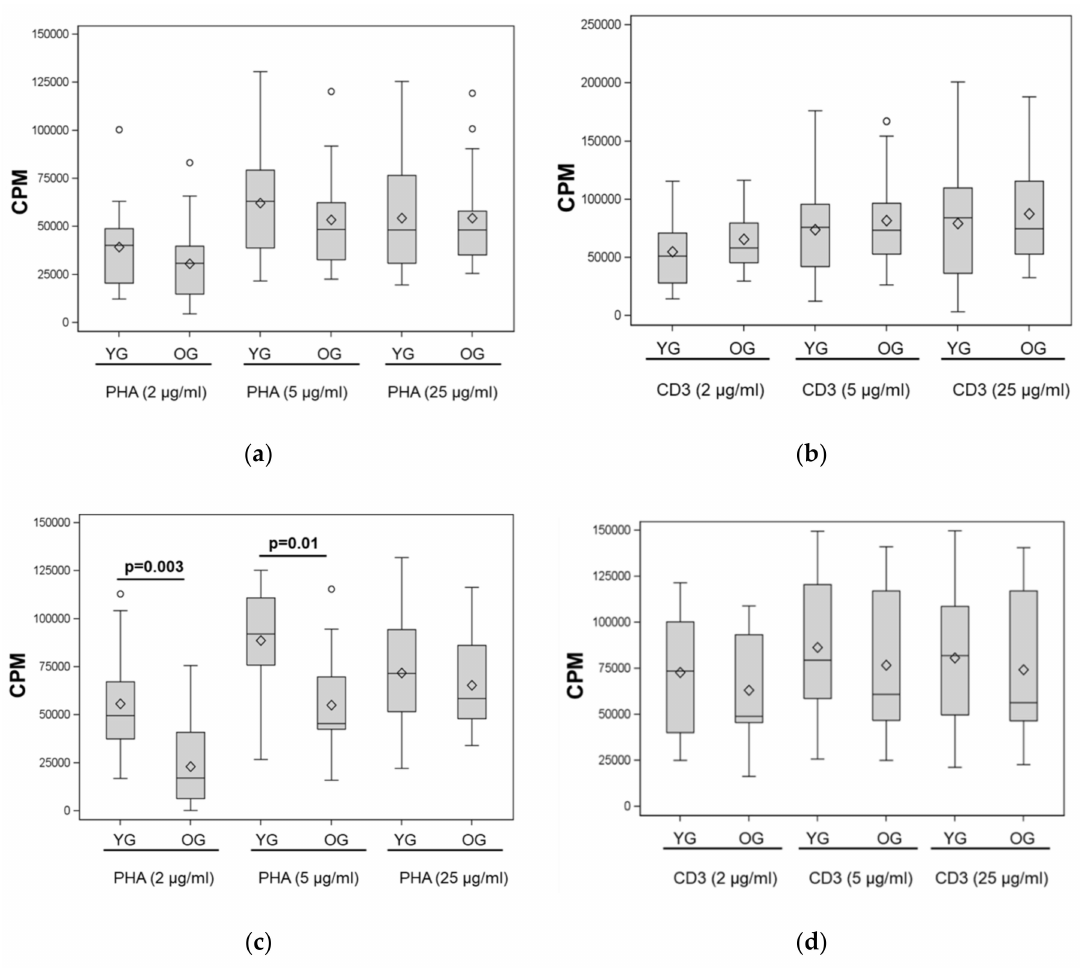
Figure 1. PHA- and anti-CD3 / CD28-stimulated lymphocyte proliferation in young and older women with obesity. PBMC from young and older women with obesity were cultured in 5% FBS ( a , b ) or 5% autologous human serum (HS) ( c , d ) for 72 h in the presence of PHA ( a , c ) or anti-CD3 / CD28 ( b , d ) at di ff erent concentrations. Medians and quartiles are shown in boxplot, means are represented by diamonds. Significance of di ff erences were determined by Wilcoxon rank sum test. The dots on the figures indicate data points that are outside of the interquartile